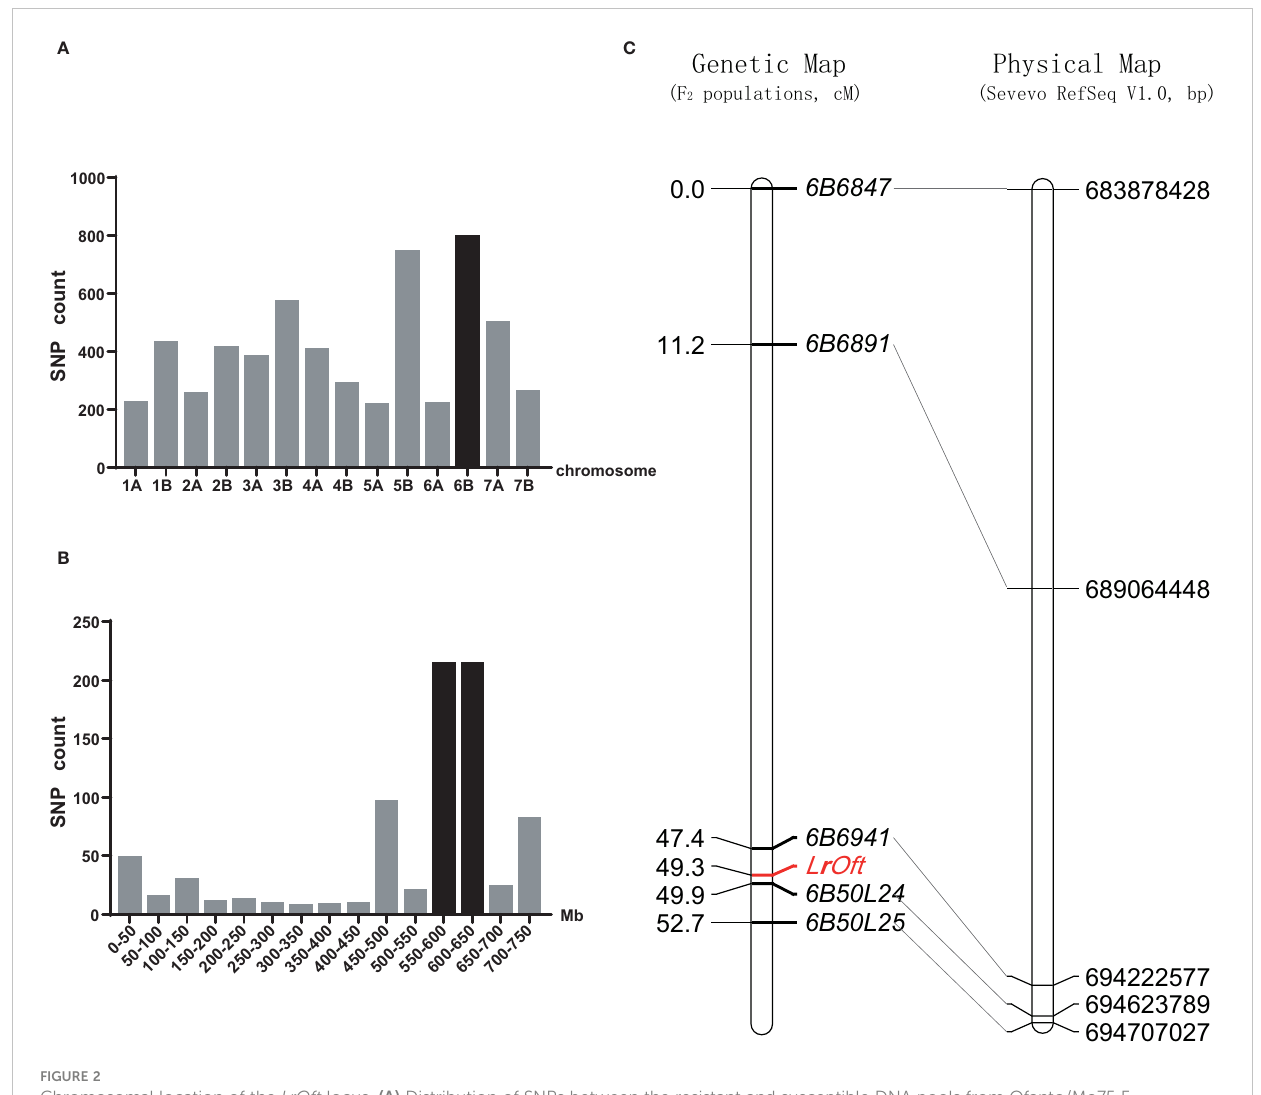
FIGURE 2 Chromosomal location of the LrOft locus. (A) Distribution of SNPs between the resistant and susceptible DNA pools from Ofanto/Mo75 F 2 population on each chromosome; (B) distribution of candidate SNPs on chromosome 6B according to durum wheat Svevo RefSeq v1.0; (C) genetic linkage map of chromosome arm 6BL and the collinearity of the developed markers with their physical positions in the durum wheat Svevo RefSeq v1.0